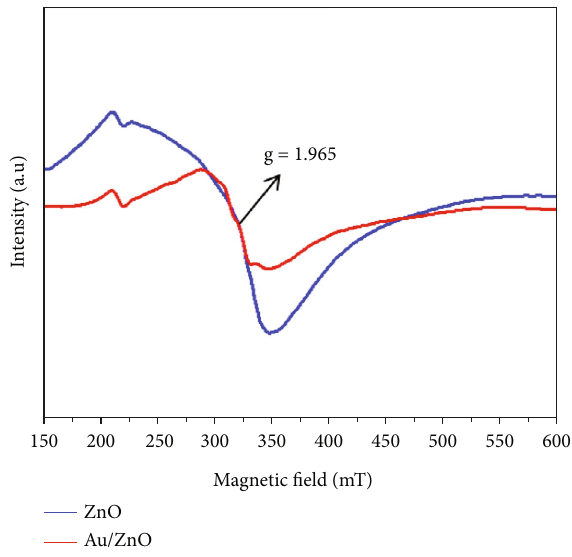
Figure 7: EPR spectra of bare ZnO and Au/ZnO-5